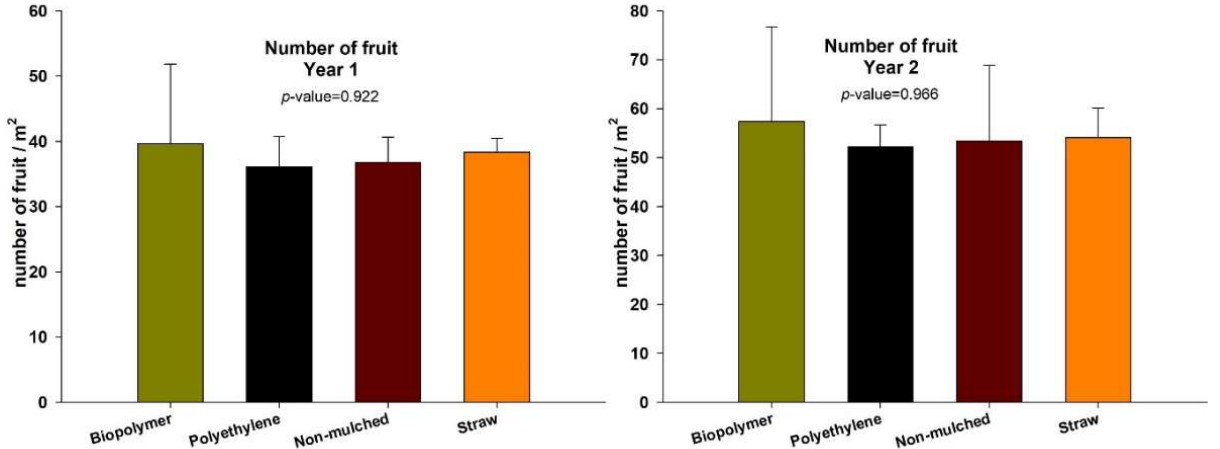
Figure 5. Number of tomato fruits per m 2 at the end of the two crop seasons depending on mulches type and non-mulched soil. Values (mean ± standard deviation; n = 3).